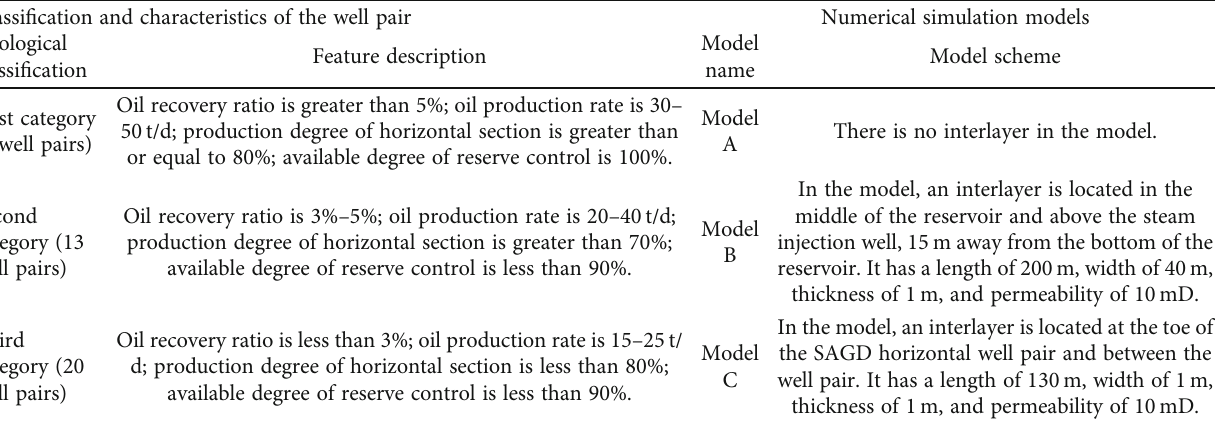
Table 1: Classi fi cation and characteristics of the well pair and numerical simulation models.